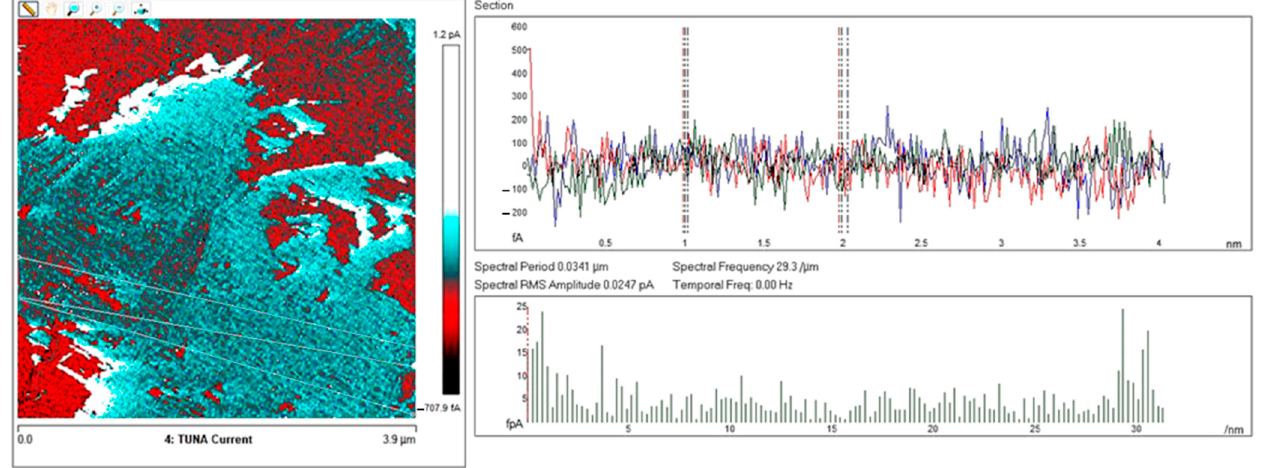
Figure 9. From left to right, TUNA Current picture and current variation profile of the sample TCTBD+2%MWCNT–b.